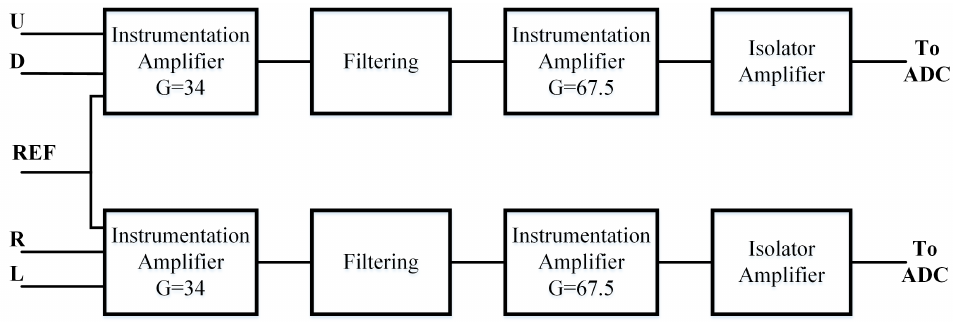
Figure 14. Block Outline of the EOG Amplifier.